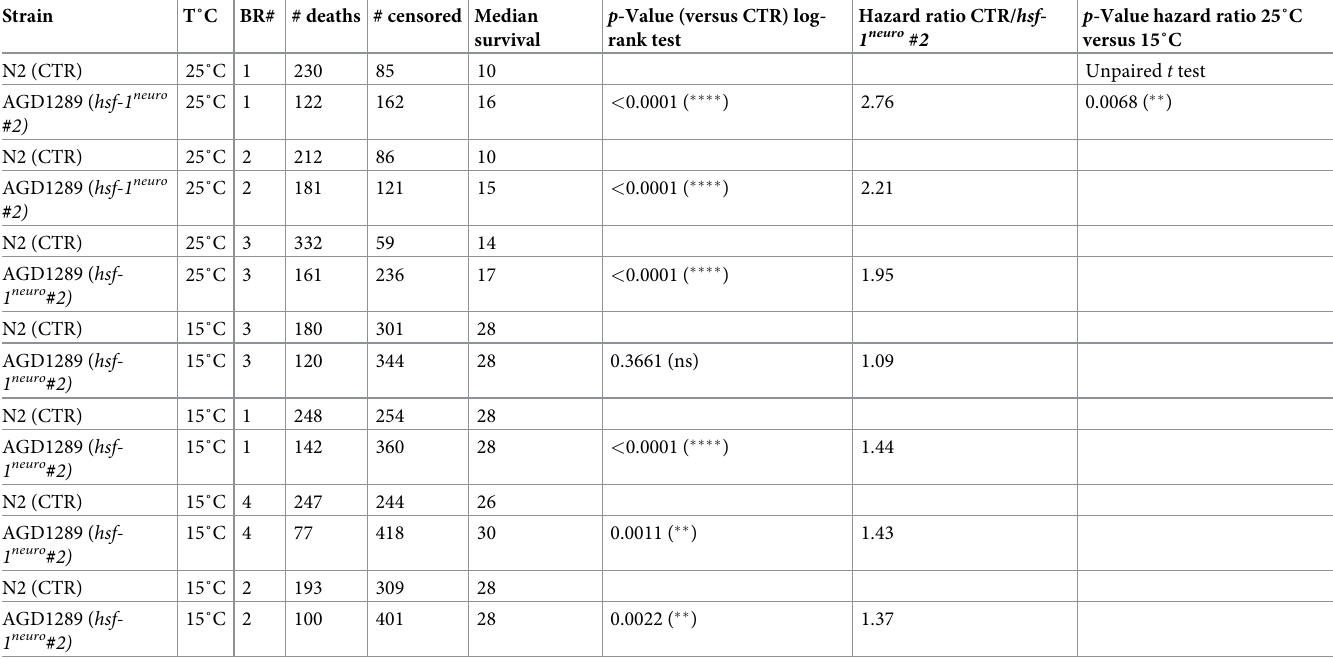
Table 1. Life span